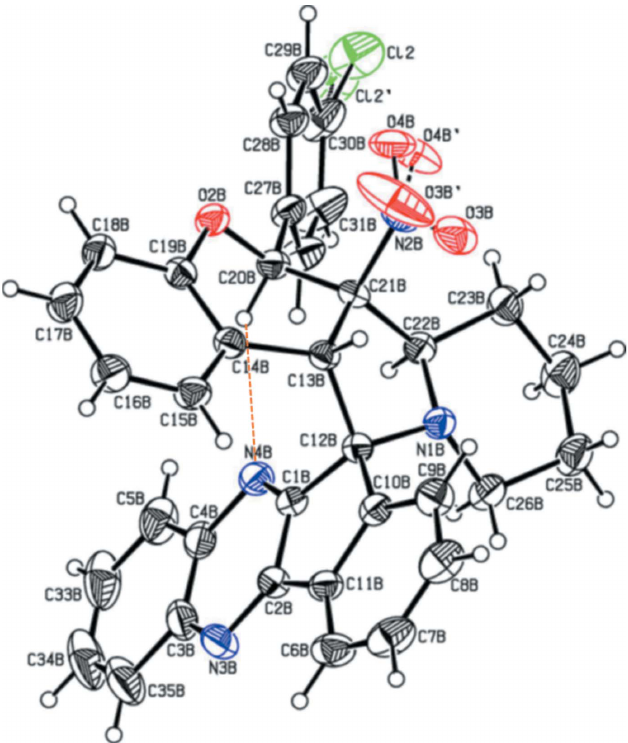
Figure 2 View of the molecular structure of molecule B of the title compound, with the atom labelling. Displacement ellipsoids are drawn at the 30% probability level. The intramolecular C—H (cid:2)(cid:2)(cid:2) N contact (Table 1) is shown as an orange dashed line.